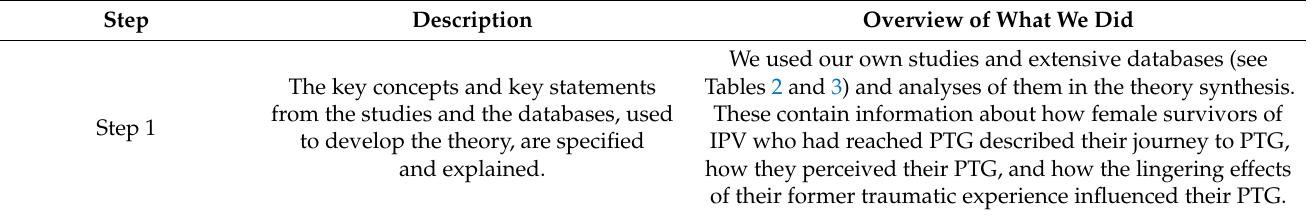
Table 1. Theory synthesis: an overview of the method and how it was used in this theory